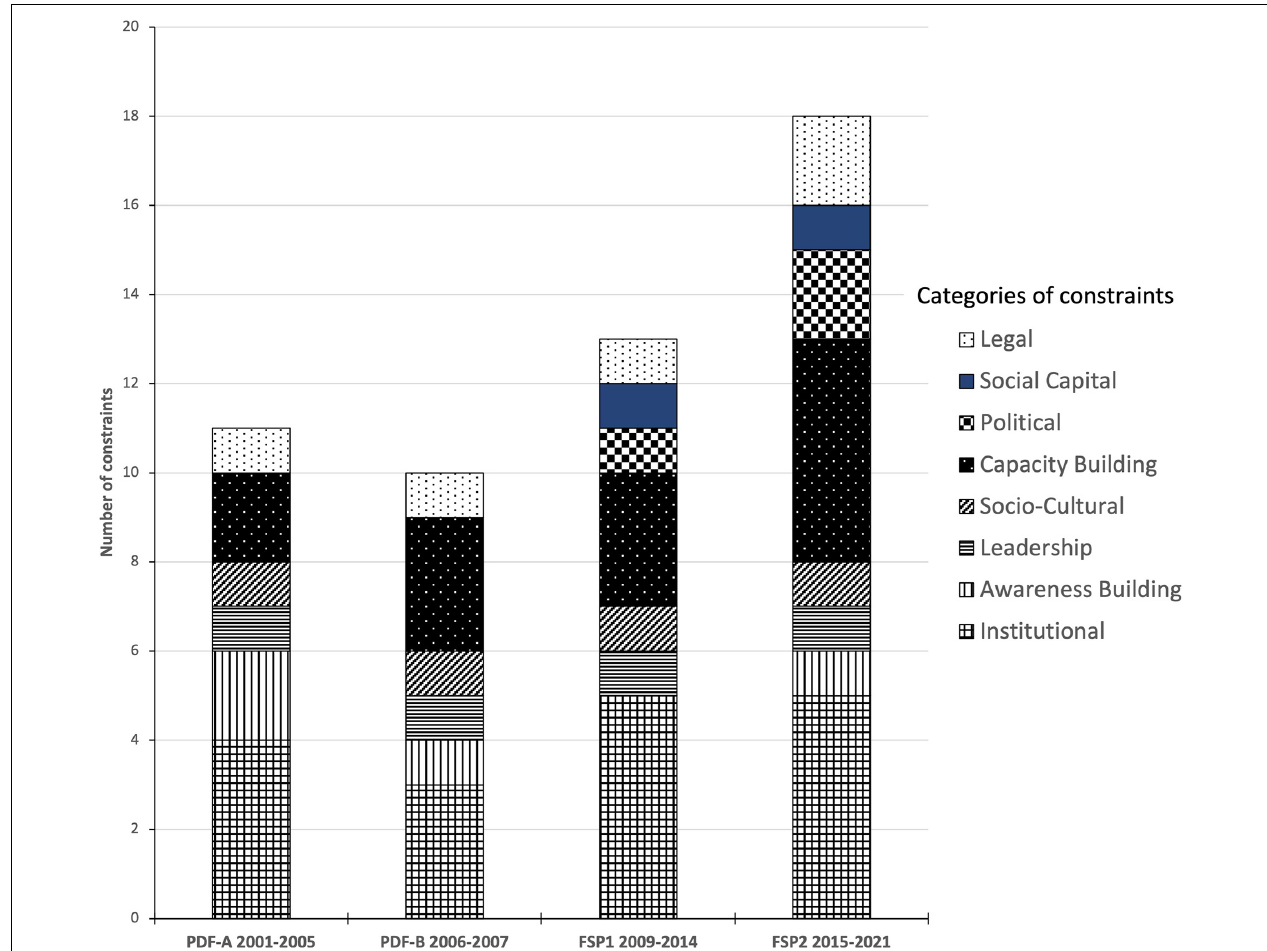
FIGURE 3 | Nature of constraints for each phase of the CLME